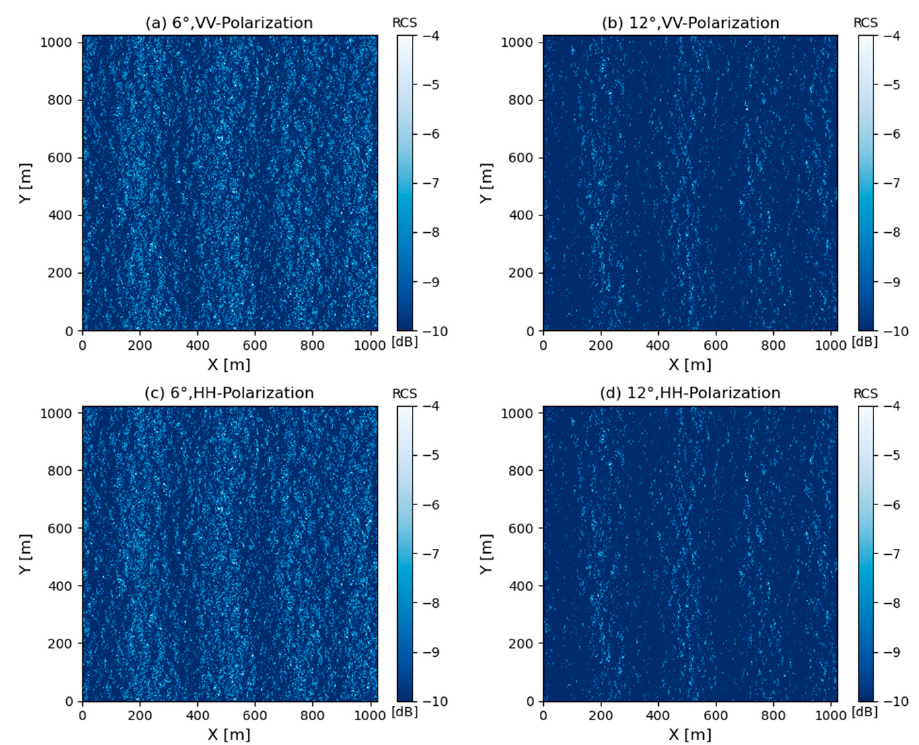
Figure 5. Sea surface backscattering coefficients obtained by different incidence angles and polarization methods, with sea surface parameters of 10 m/s wind speed, swell wavelength of about 300 m, and effective wave height of 4 m.